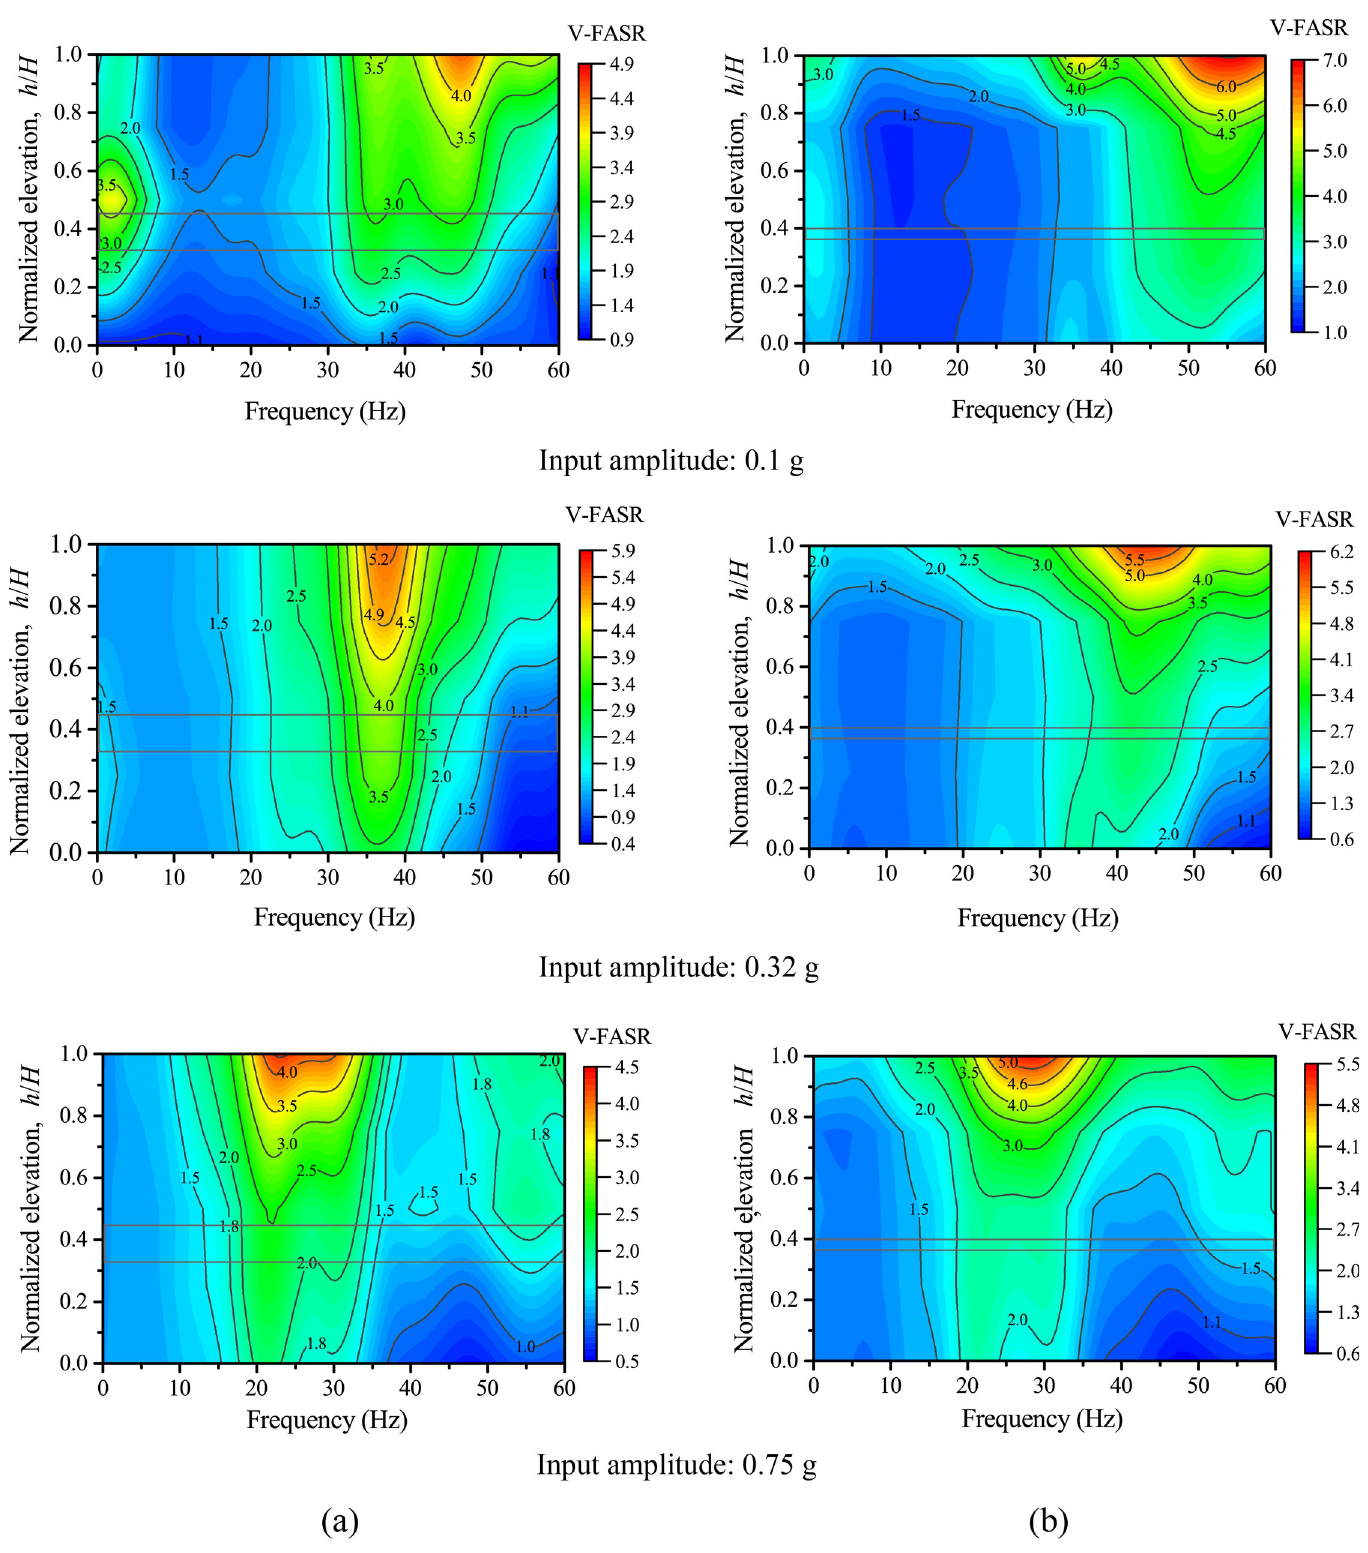
Fig 12. Fourier amplitude spectral ratios of vertical accelerations (V-FASR) under different levels of vertical shakings: (a) Slope A; (b) Slope B.